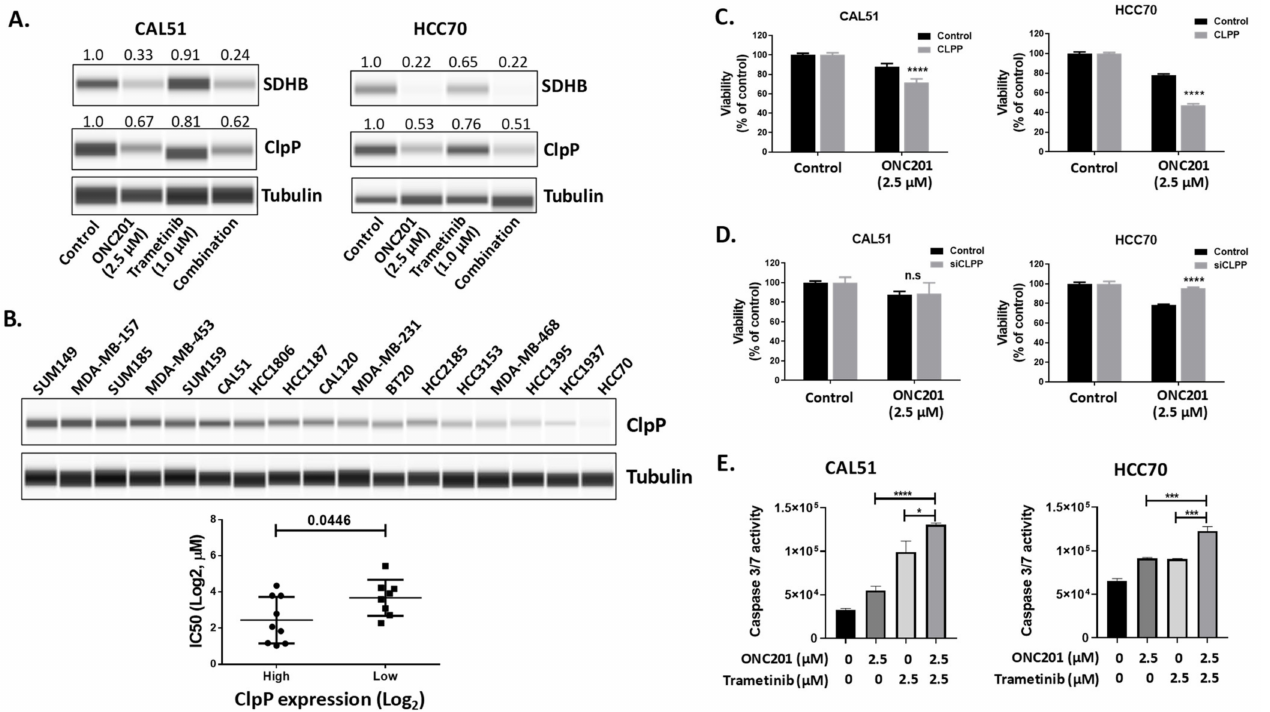
Figure 4. Assessment of the known direct targets of ONC201, SDHB, and ClpP in TNBC cell lines. Cells were treated with DMSO control, ONC201 alone (2.5 µ M), trametinib alone (1 µ M), or a combination of ONC201 and trametinib. ( A ) Western blots showing that ClpP and SDHB levels were markedly reduced by ONC201 in both ONC201-sensitive (CAL51) and -resistant (HCC70) TNBC cell lines. ( B ) Western blot data showing that the median level of ClpP expression was significantly correlated IC 50 of ONC201 in TNBC cell lines ( p = 0.0446). ( C , D ) The cells transfected with a ClpP expression vector or siRNA for 48 h and then treated with ONC201 for 5 days, and then cell viability was measured by sulforhodamine B assay. ( E ) Graphs showing that treatment with ONC201 in combination with trametinib induced caspase 3/7 activity in CAL51 and HCC70 cells. Cells were treated with ONC201 (2.5 µ M) with or without trametinib (1 µ M) for 24 h, and a caspase 3/7 activity assay was performed. n.s, not significant, * p < 0.05; *** p < 0.001; **** p < 0.0001 (unpaired Student t